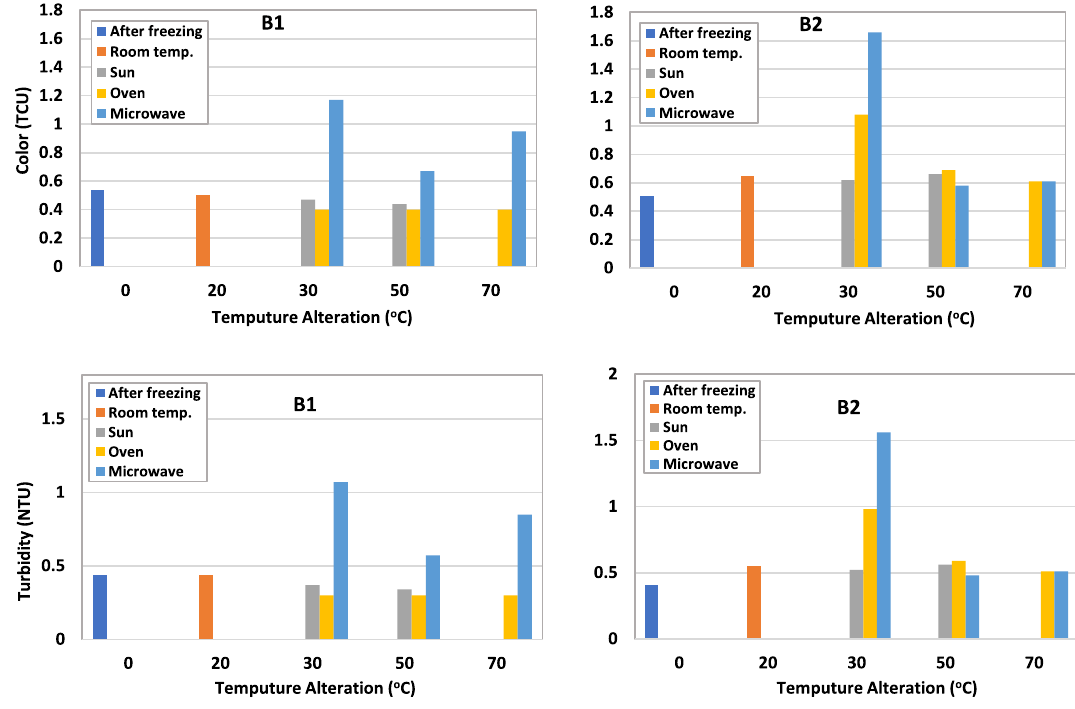
Fig. 2 Color and turbidity measurements at different heating degrees for brands B1 and B2